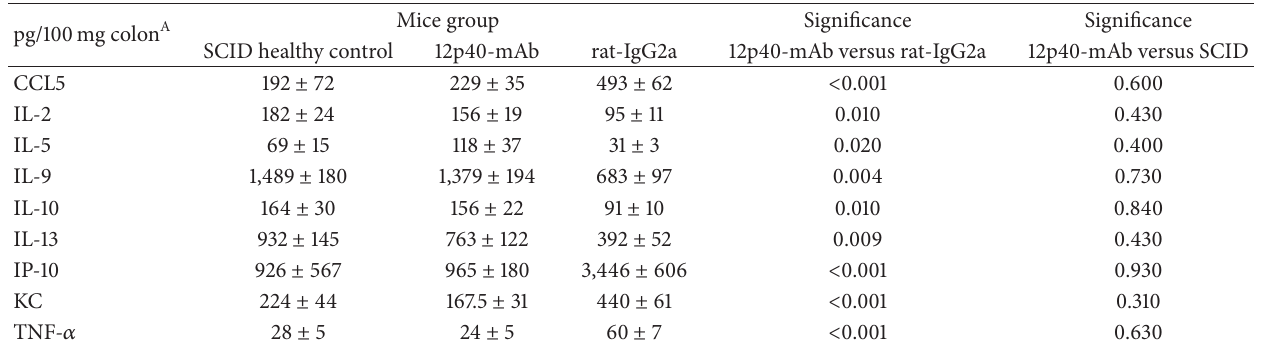
Table 1: Cytokine and chemokine levels in